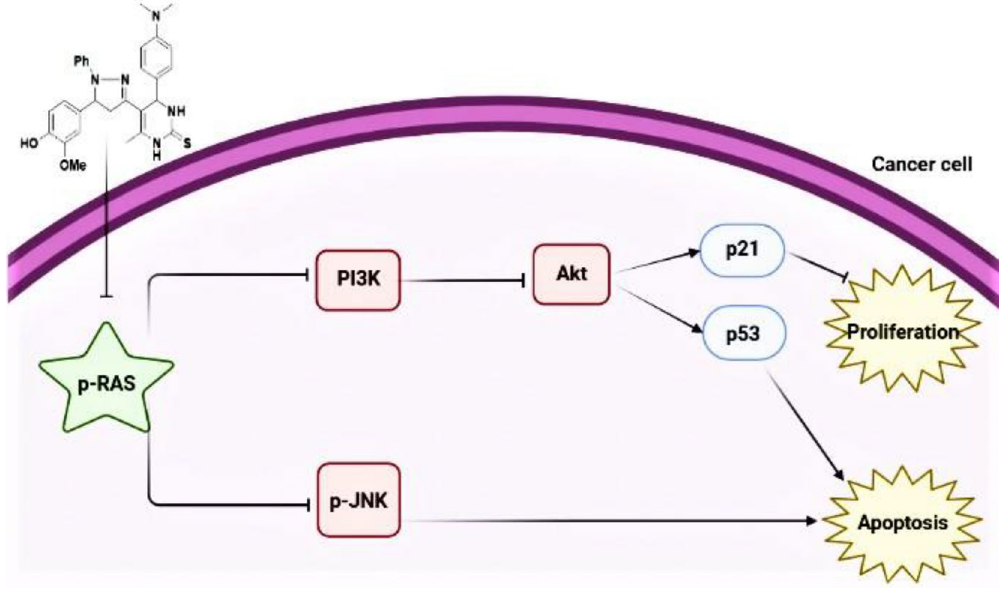
Figure 11. Systematic design for the effect of compound 5a as inhibitor of breast carcinoma cell